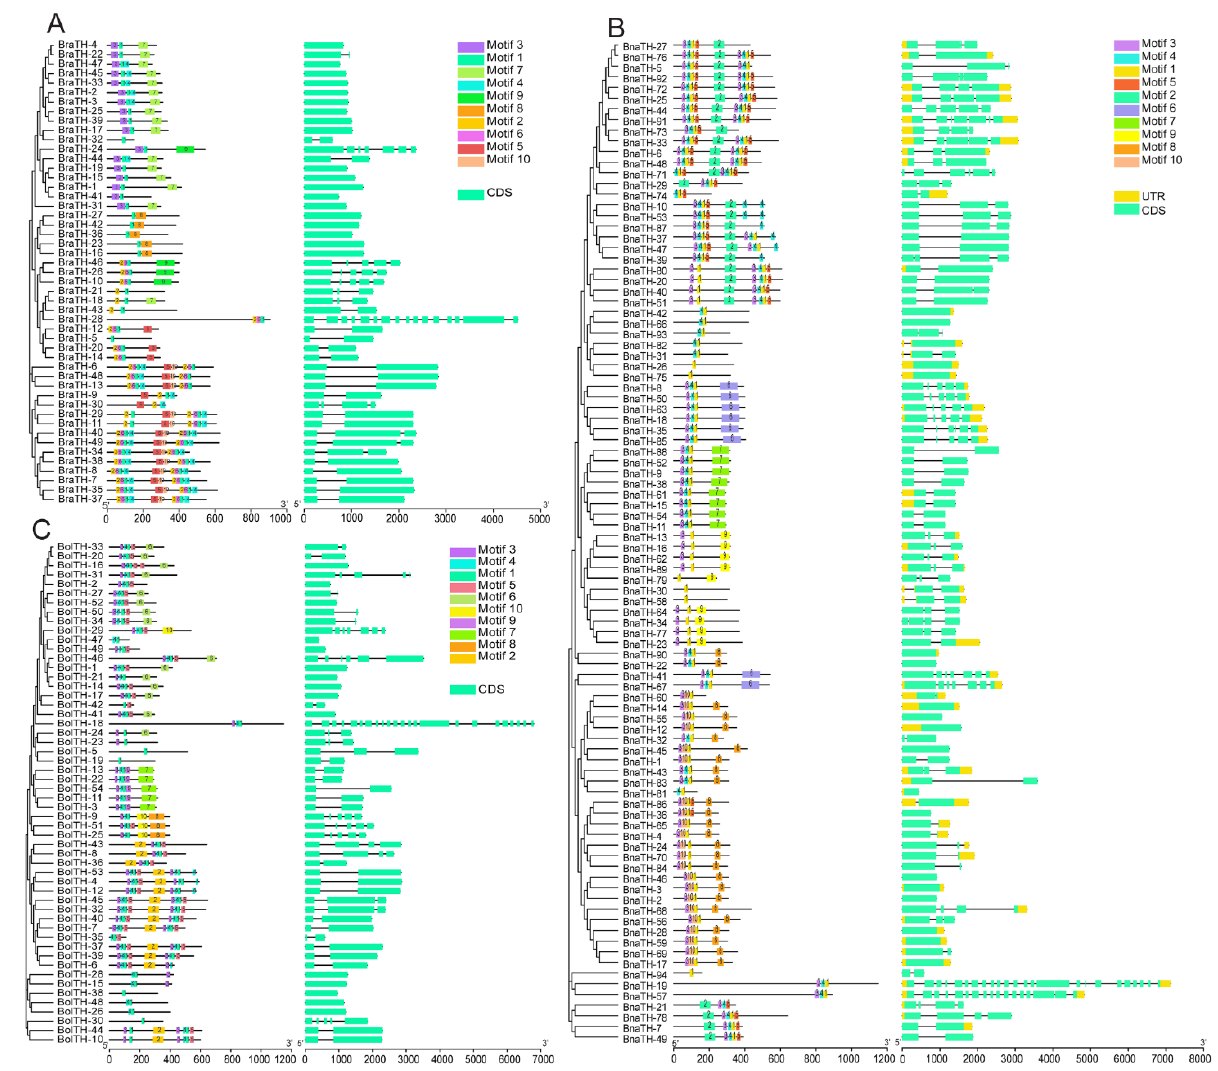
Figure 2. Comparative analysis of conserved domains and gene structures of BraTH genes, BolTH genes, and BnaTH genes. The colored boxes with numbers indicate the different conserved motifs identified by MEME. The scale bar at the bottom estimates the lengths of the motifs, exons, and introns. ( A ) Phylogenetic relationships, conserved protein motifs, and gene structures of 49 BraTH genes. ( B ) Phylogenetic relationships, conserved protein motifs, and gene structures of 94 BnaTH genes. ( C ) Phylogenetic relationships, conserved protein motifs, and gene structures of 54 BolTH genes.